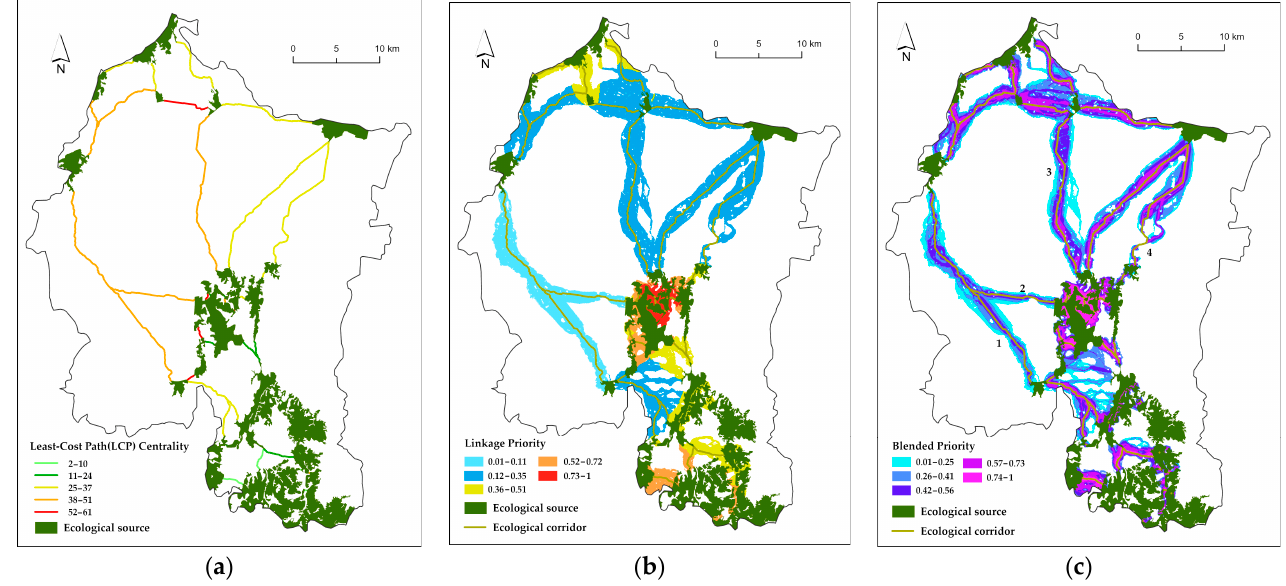
Figure 12. Analyses of ecological corridors. ( a ) Analysis of least-cost path centrality; ( b ) analysis of linkage priority; ( c ) analysis of blended priority.